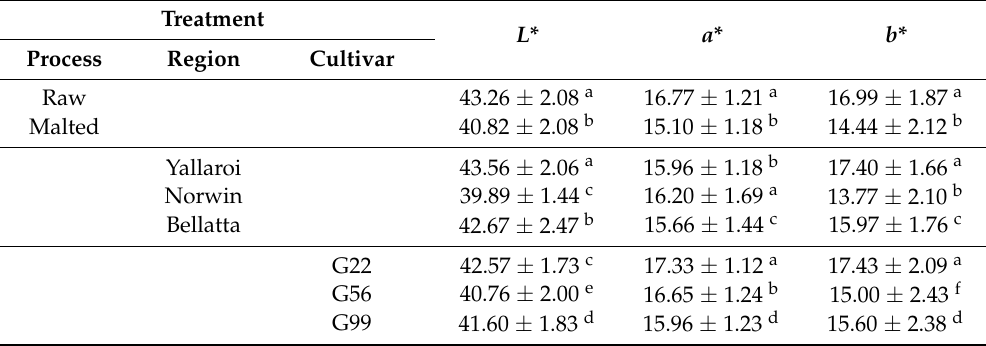
Table 1. Overall mean comparisons for colour of Australian-grown sorghums between processes (raw versus malted), regions and cultivars. Values are means ±